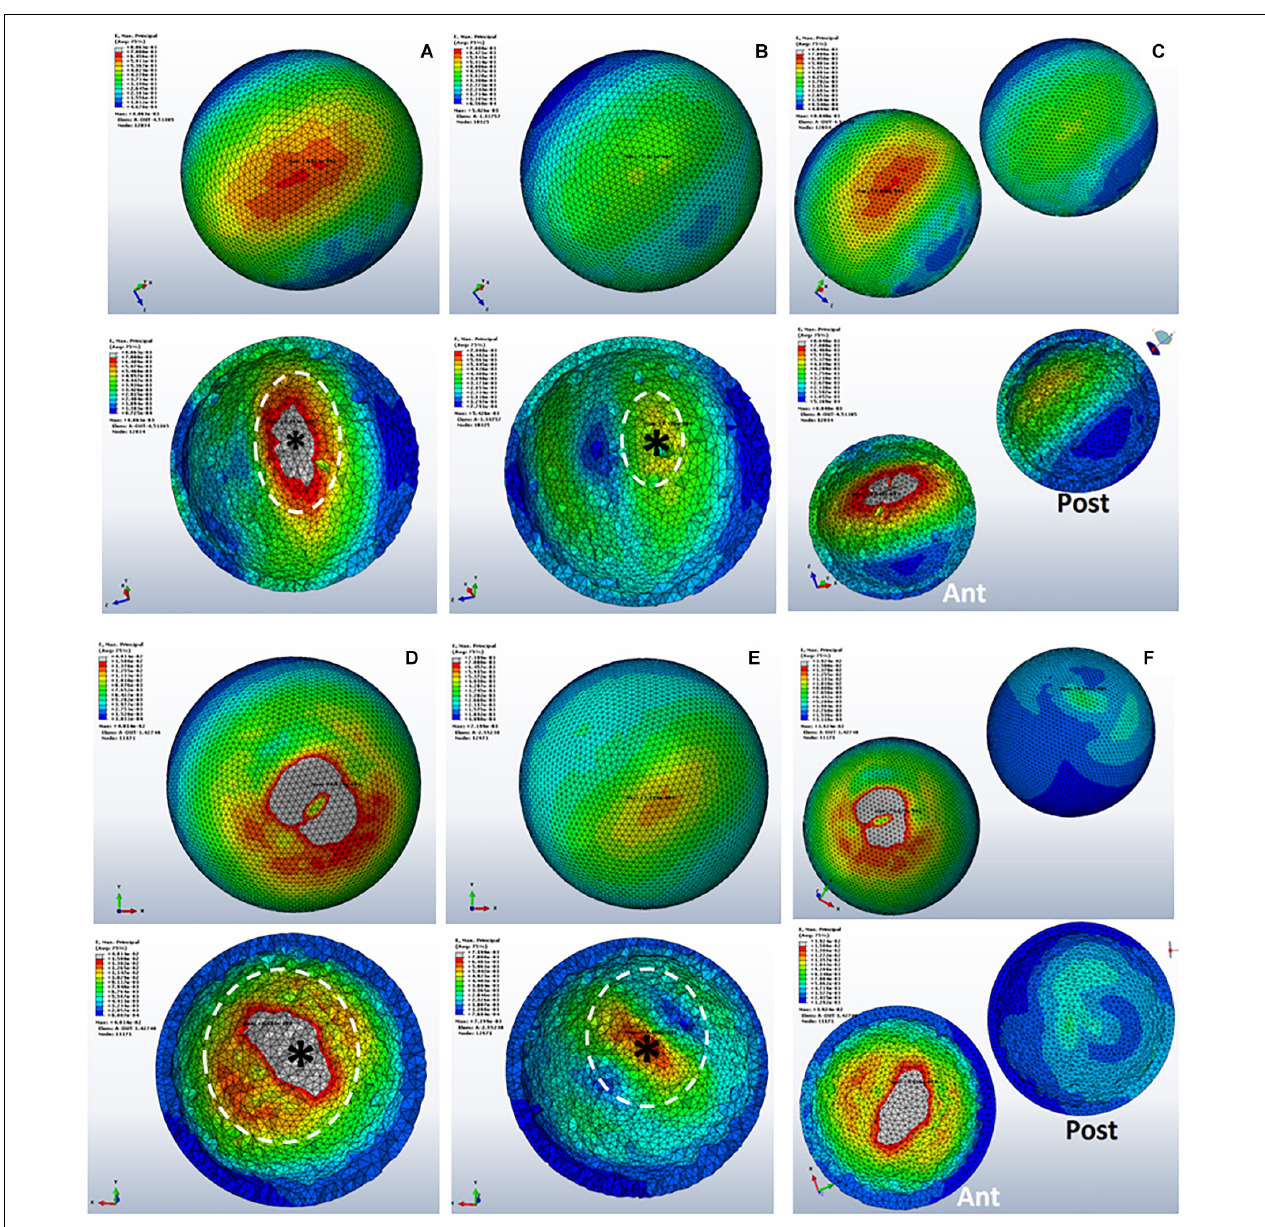
FIGURE 5 | Strain distributions in SBCs. (A–C) Representing sub-groups 1, 2, and 3 of group B. Panels (D–F) showing sub-groups of group C with corresponding inner sections of cysts. The peak strain is pointed by “*,” and the dotted circle shows the direction of strain spread. SBCs, subchondral bone cysts.